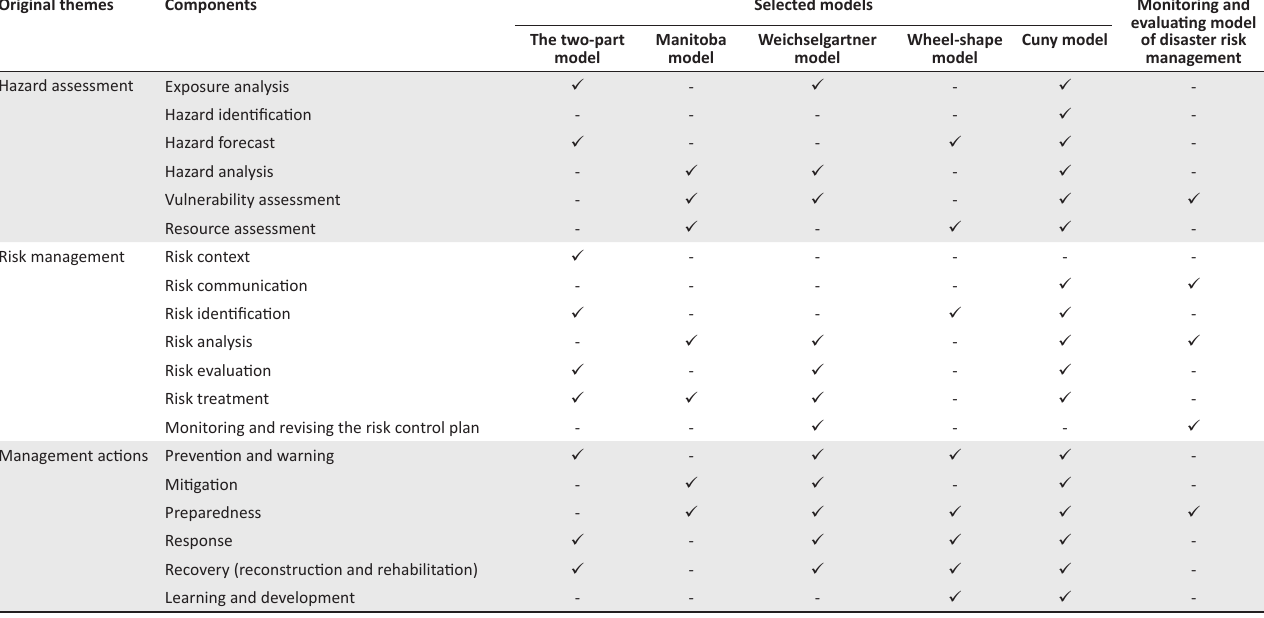
TABLE 4: Typology of disaster management models (second